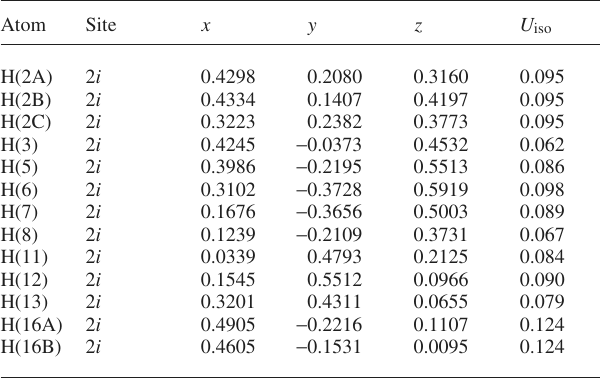
Table 2. Atomic coordinates and displacement parameters (in Å 2 )